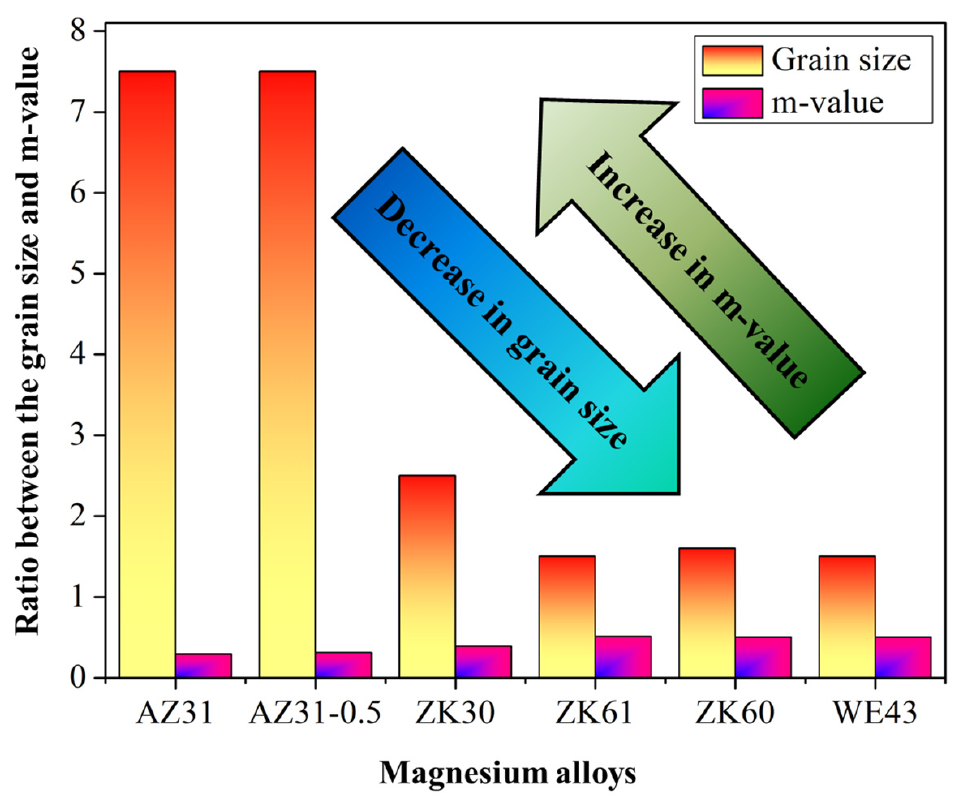
Figure 1. The statistical graph of grain size and m-value of given alloys [14–18] (the grain size of ZK30 Mg alloy was 1–5 µ m and 30 µ m; however, for the graphical presentation, we use an average of 2.5 µ m) .